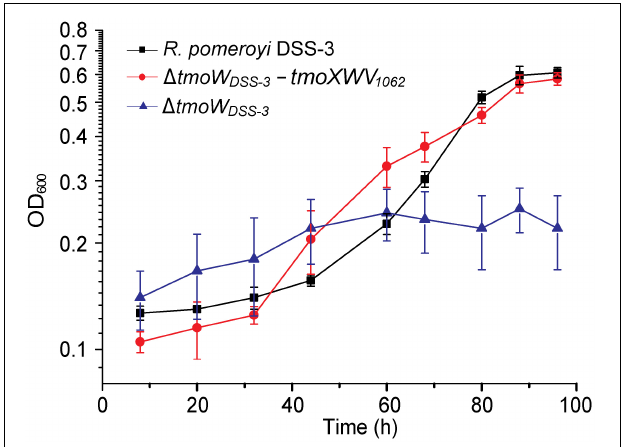
FIGURE 3 | Growth curves of the WT R. pomeroyi DSS-3, the (cid:49) tmoW DSS − 3 mutant, and the complemented mutant (cid:49) tmoW DSS − 3 - tmoXWV 1062 . All strains were cultivated with TMAO (2 mM) as the sole nitrogen source. The error bar represents standard deviation of triplicate